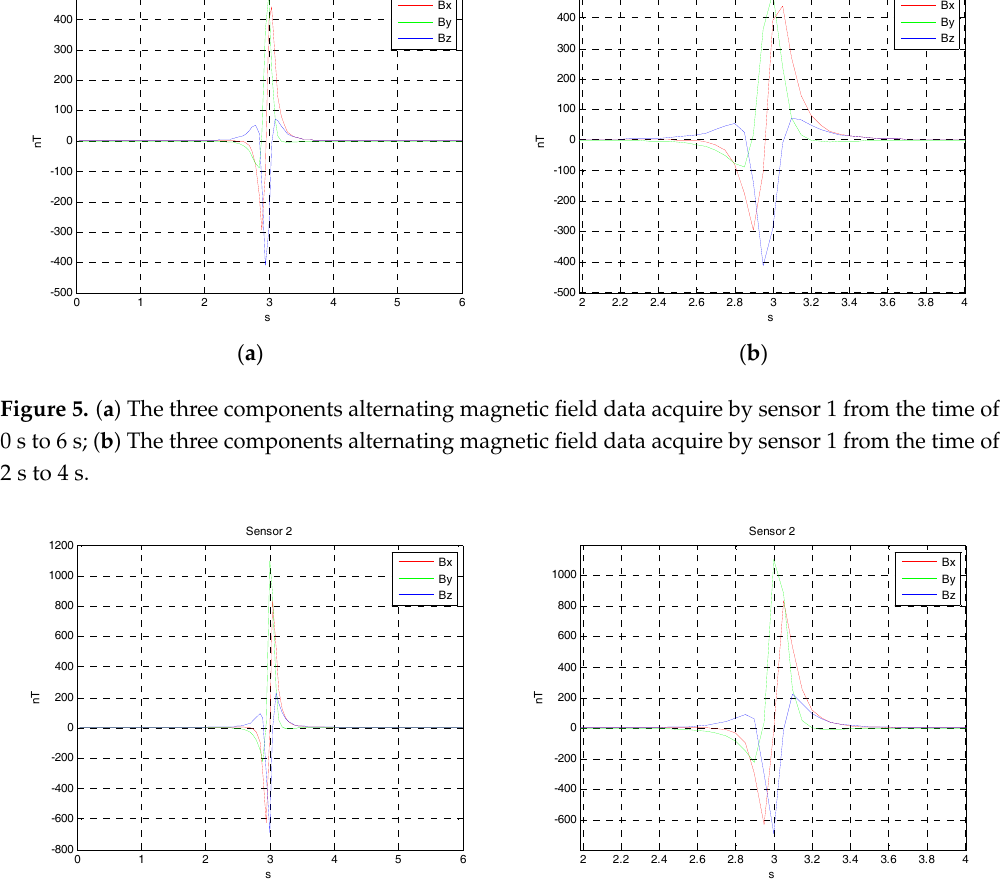
Figure 7. ( a ) The three components alternating magnetic field data acquire by sensor 3 from the time of 0 s to 6 s; ( b ) The three components alternating magnetic field data acquire by sensor 3 from the time of 2 s to 4 s. The L-M algorithm was applied to get the position and rotation angle of the moving target with magnetic field data acquired by the sensors array. Using the solution for a class of nonlinear unconstrained optimization problem derived in Equation (7), the results of localization for moving ferromagnetic target which has roll, pitch or yaw in its movement could be shown in Figures 8 and 9.